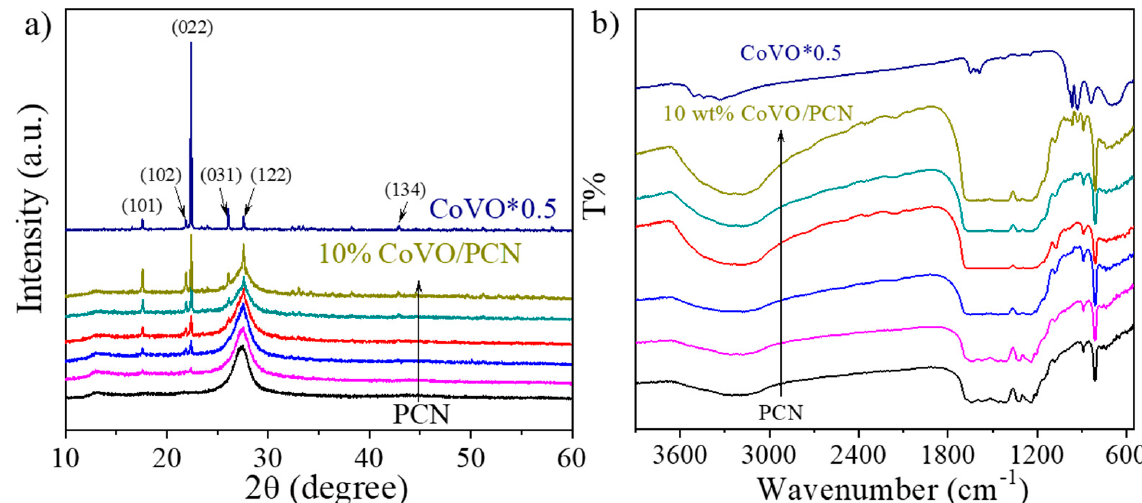
Figure 1. ( a ) Powdered XRD patterns; ( b ) FT − IR spectra of x wt % CoVO/PCN samples (black: PCN, violet: 1 wt %, blue: 2 wt %, red: 3 wt %, green: 5 wt %, beige: 10 wt %, navy: CoVO*0.5, Peak intensity decreased by 0.5 times).